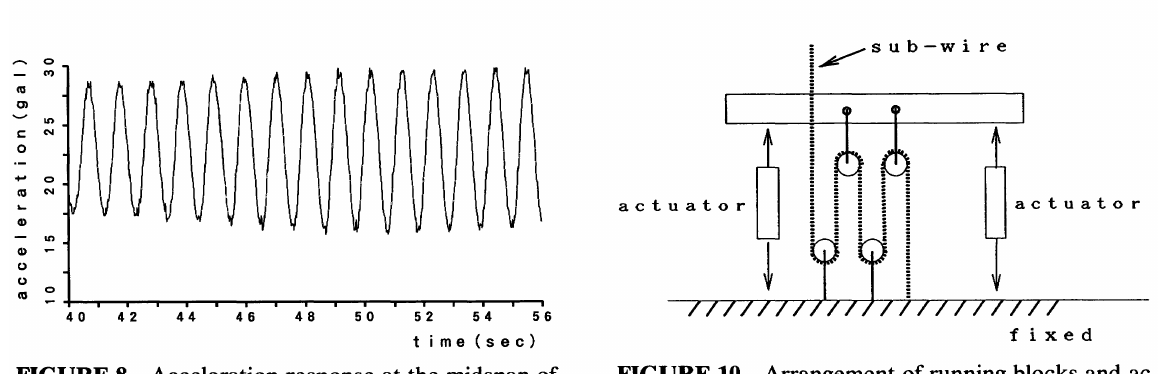
FIGURE 8 Acceleration response at the midspan of the bridge.